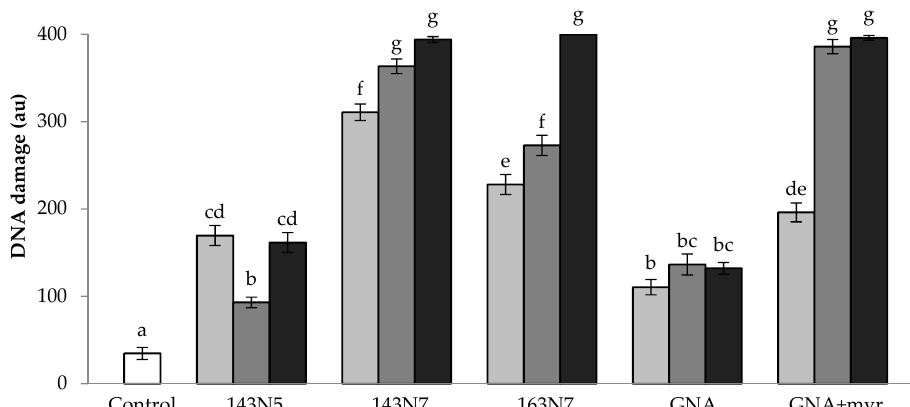
Figure 5. The level of DNA damage in treated HL-60 cells. Greyscale represents increasing concentrations of Brassica rapa (0.31, 0.625 and 1.25 mg/mL) and hydrolyzed and non-hydrolyzed gluconapin (0.0069, 0.0137 and 0.025 mg/mL) samples, the white column being the non-treated ones (control). Columns with the same letters do not differ at a level of 5% significance on the Tukey’s test.